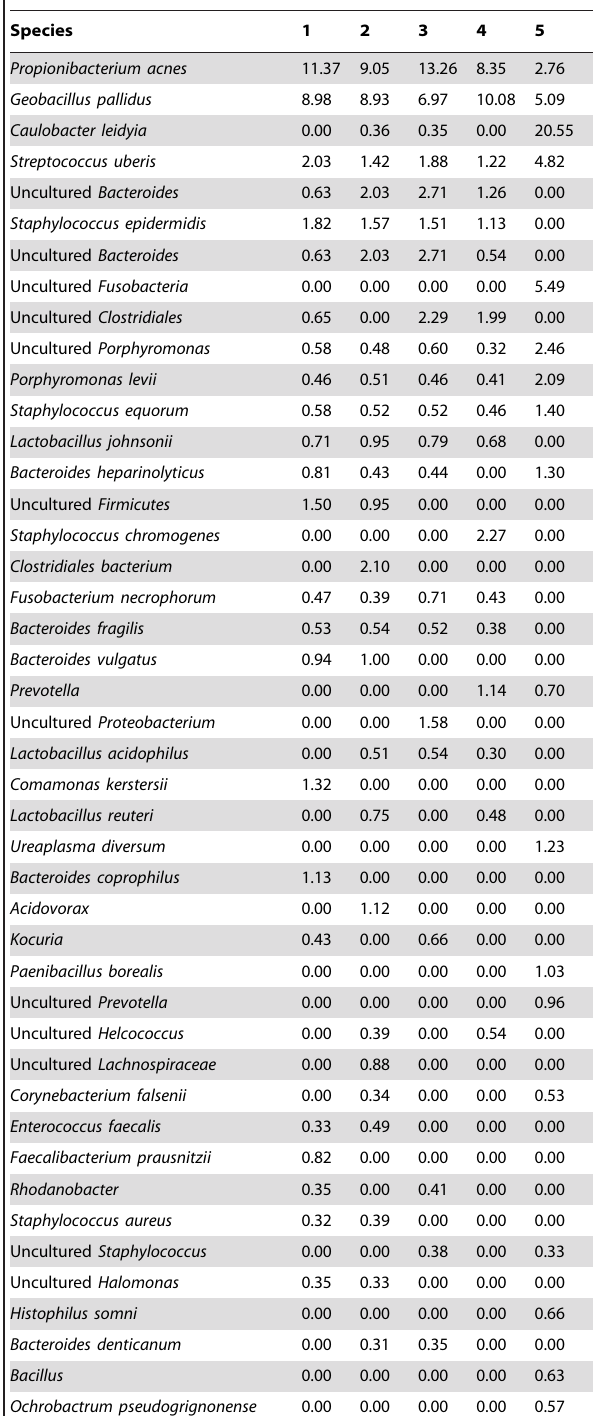
Table 1. Prevalences of known bacterial species in each group of milk samples (1=healthy quarter, somatic cell count , 20,000; 2= culture negative quarter, somatic cell count ranged from 21,000 to 50,000; 3=culture negative quarter, somatic cell count . 50,000; 4=non-clinical culture positive quarters, somatic cell count . 400,000; 5=clinical mastitis culture negative